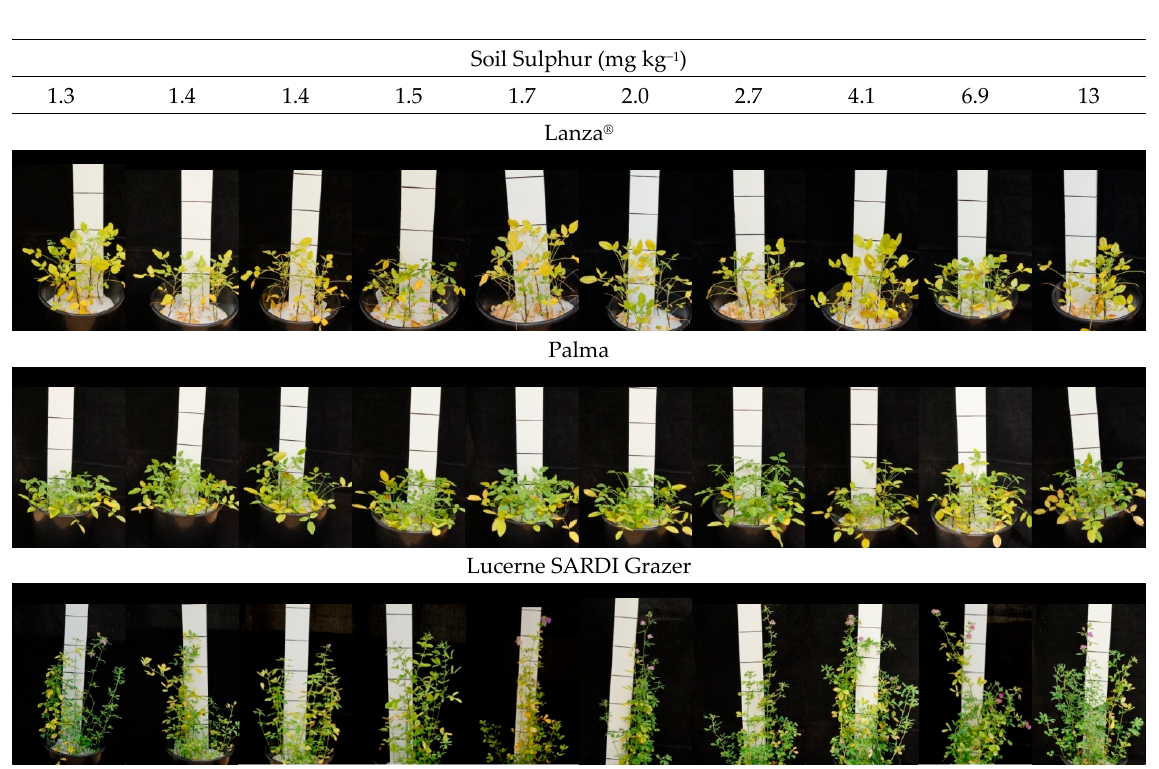
Figure 4. Images of pots containing 12-week-old Lanza ® (top), Palma (middle), and lucerne (bottom) grown in the glasshouse with differing levels of Colwell K in soil. Black lines on large scale bars are 10 cm intervals.